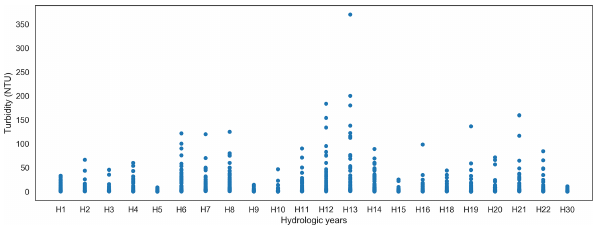
Figure A1. Scatter plot of turbidity time series recorded at the water treatment plant in the Radicatel catchment, Normandy, France.